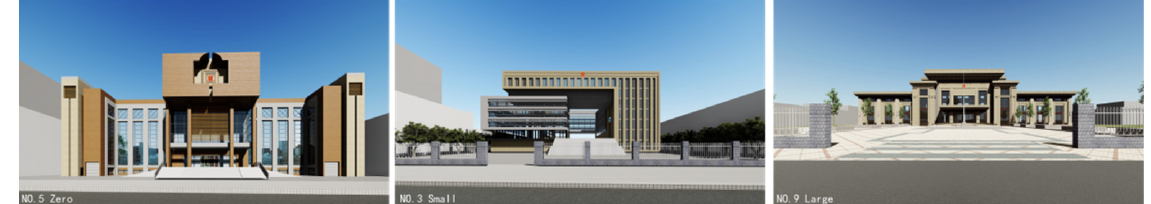
Figure 3. Three types of open ground in front of courthouse buildings (increasing in size from left to right).